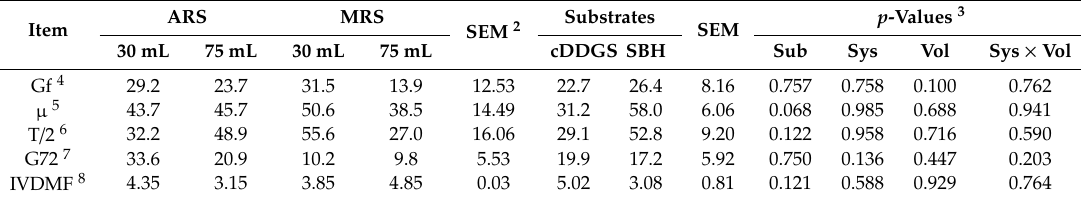
Table 2. Average coe ffi cient of variation of the in vitro fermentation kinetic parameters for corn distillers dried grains with solubles (cDDGS) and soybean hulls (SBH) using an automatic recording system (ARS) and manual recording system (MRS) with two di ff erent pig fecal inoculum volumes (30 and 75 mL) 1